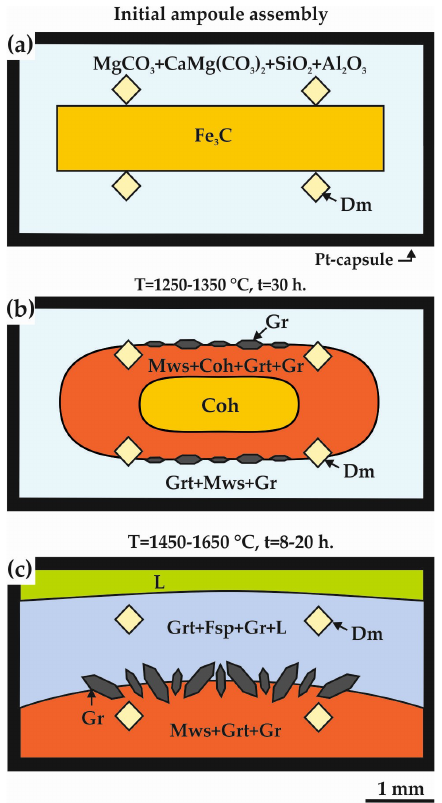
Figure 1. Schemes of carbide–oxide–carbonate interaction after “sandwich-type” experiments (Fe 3 C-Al 2 O 3 -SiO 2 -(Mg,Ca)CO 3 system, P = 7.5 GPa): ( a ) initial ampoule assembly (before experiments); ( b ) samples after experiments at 1250–1350 ◦ C, t = 30 h; and ( c ) samples after experiments at 1450–1650 ◦ C, t = 8–20 h. Grt, garnet; Coh, cohenite; Mws, magnesiowustite; Fsp, ferrospinel;